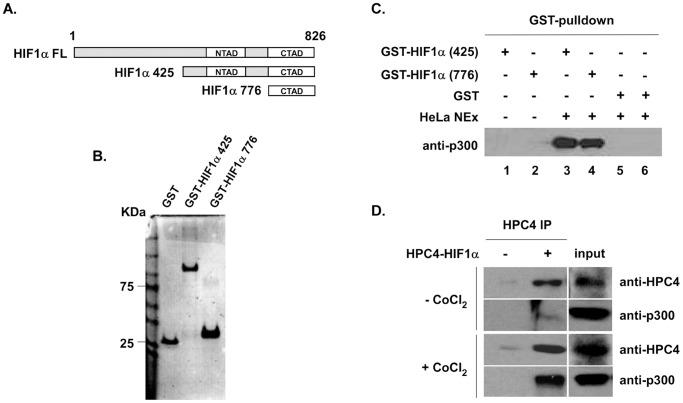
HIF1αCTAD interacts with p300.
A. Deletion structure of HIF1α. The schematic diagram indicates their length and location compared with full-length HIF1α. B. Fragments of HIF1α were cloned and expressed as His-GST fusion proteins and were analyzed by SDS-PAGE (4–20% gradient gel, BioRad). Proteins were visualized by Coomassie Blue staining. C. Deletion HIF1α 425 and HIF1α 776 bind to endogenous p300: ∼10 µg of bacterially expressed and GST purified HIF1α 425 and HIF1α 776 (CTAD) were mixed with 100 µl of HeLa nuclear extract and 15 µl of glutathione-sepharose 4 Fast Flow beads (Amersham Biosciences) in binding buffer containing 40 mM Tris-HCl (pH 7.4), 150 mM NaCl, and 0.2% (v/v) Triton X-100. Protein mixtures were incubated for 4 hours at 4°C and bound proteins were eluted with elution buffer containing 25 µl of 30 mM glutathione, 40 mM Tris-HCl (pH 7.5), 10% (v/v) glycerol, and 150 mM NaCl. Pulled-down p300 was confirmed by Western blotting with anti-p300 antibody. D. Overexpressed full length (FL) HIF1α interacts with endogenous p300 in the presence or absence of CoCl2. HeLa cells were transiently transfected with 1 µg of HPC4-HIF1α. Hypoxia conditions were induced by adding CoCl2 (Sigma, 150 µM). Proteasome inhibitor MG132 (50 µM) was added to block protein degradation and assess the total amount of HIF1α 3 hours before harvest. Then, 72 hours after HPC4-HIF1α transfection, cells were harvested and lysed for immunoblot.